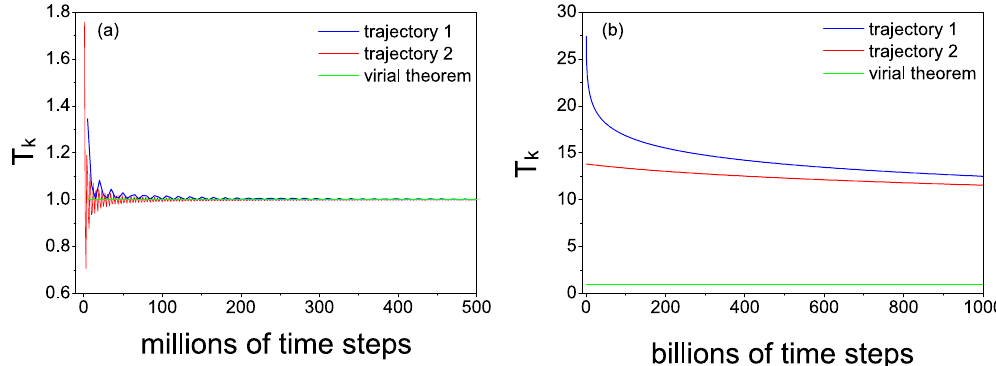
Figure 3. T k as a function of the average time for an isolated oscillator with the total energy ( a ) E = 5 and ( b ) E = 25. The average is along two typical trajectories (see text for details) denoted by the blue line and the red line, respectively. The prediction by the virial theorem ( T k = P k ) is drawn by green lines as a reference. Here τ = 1, ε = 0.0001, the relaxation time is given by 10 8 time steps. Note that the time unit of the right plot is billions (10 9 ) of time steps. For such a long-time simulations, the energy drift in our simulations is controlled in the order of 10 − 4 (trajectory 1) and 10 − 7 (trajectory